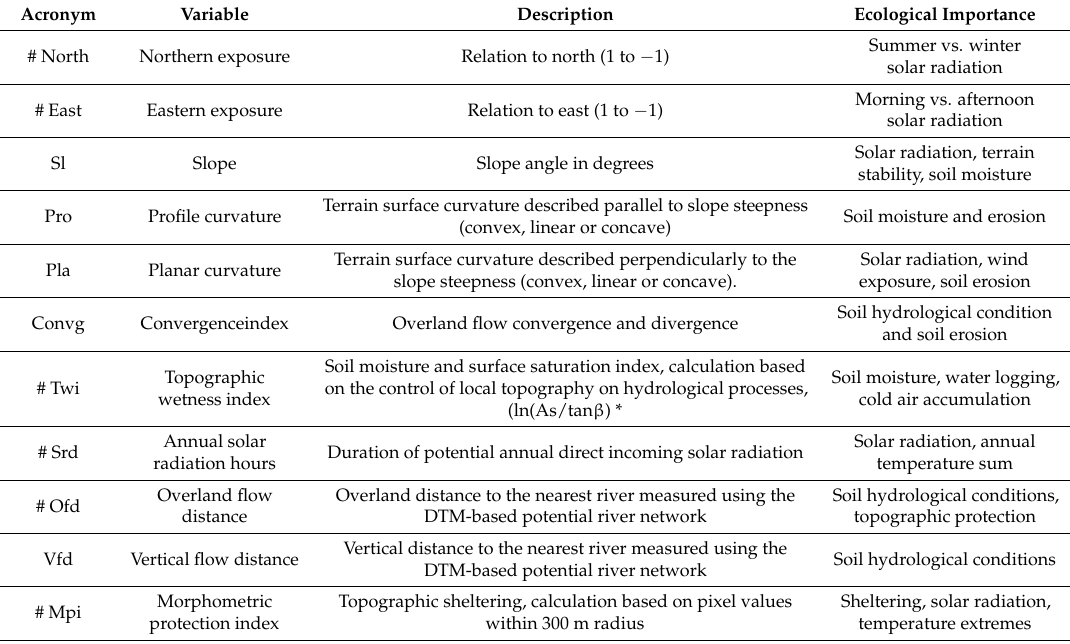
Table 1. The selected topographic features and indices derived from the digital terrain model (DTM) of spatial resolution 30 m × 30 m, their descriptions, and ecological importance. The weakly correlated variables (Spearman’s rank correlation coefficient <0.5) included in the GLMs are marked with a hash